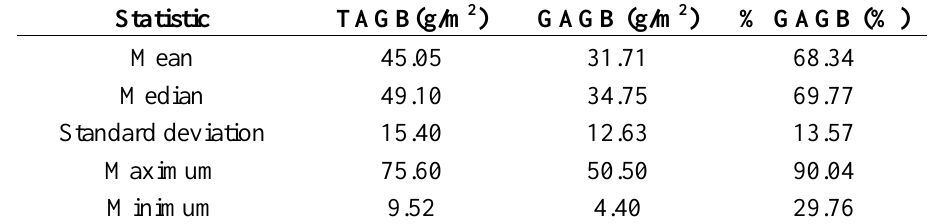
Table 2. Descriptive statistics of the sample ( n = 30) (TAGB: total aboveground biomass, GAGB: green portion of the AGB, % GAGB: Percentage of the green faction of the AGB).